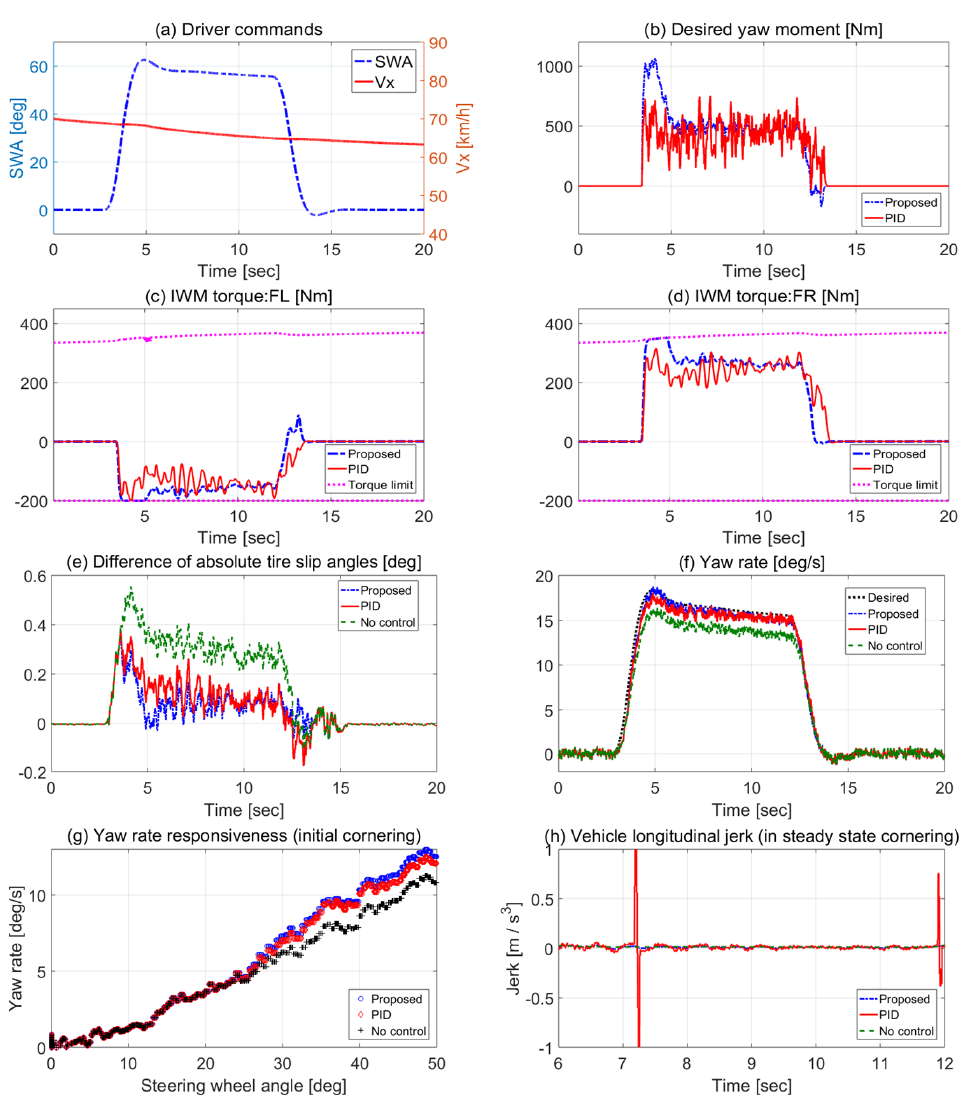
Figure 7. Simulation results of circle turn test (vs. PID controller). ( a ) Driver commands. ( b ) Desired yaw moment. IWM torques: ( c ) FL, and ( d ) FR. ( e ) Difference in absolute tire slip angles. ( f ) Yaw rate. ( g ) Yaw rate responsiveness (in initial cornering). ( h ) Vehicle longitudinal jerk (in steady state cornering).